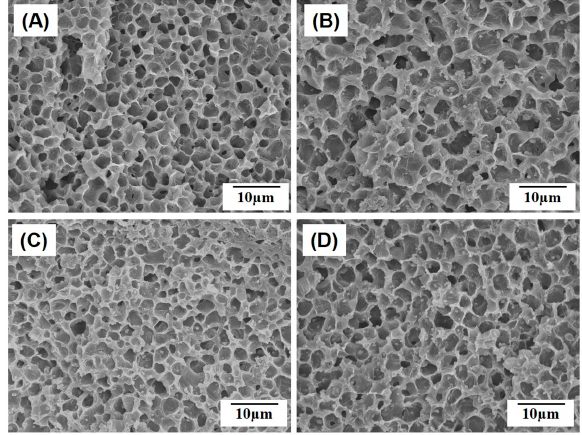
Figure 4. Representative FE-SEM images of the highly microporous PCL/HA composite struts produced with various HA contents of ( A ) 0 wt %; ( B ) 10 wt %; ( C ) 15 wt %; and ( D ) 20 wt %.